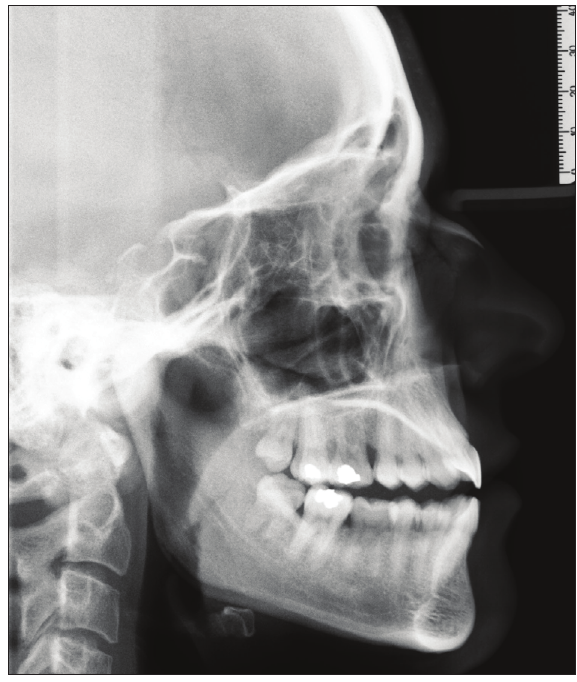
Figure 3. Pretreatment panoramic radiograph.